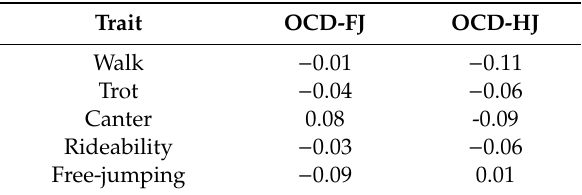
Table 3. Additive genetic correlation between osteochondrosis dissecans (OCD) and selected performance traits for mare performance test.